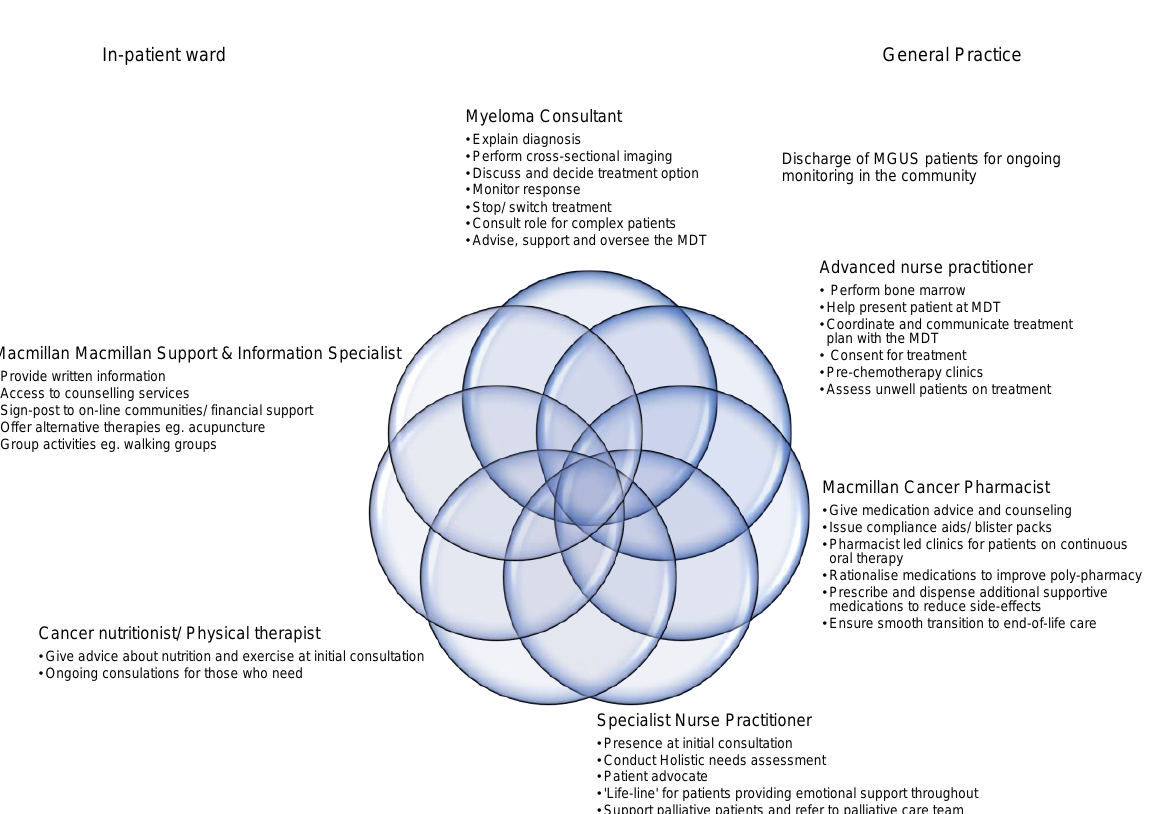
Figure 1. Schematic demonstrating each member in the multidisciplinary team and their role in the care of the patient with multiple myeloma.